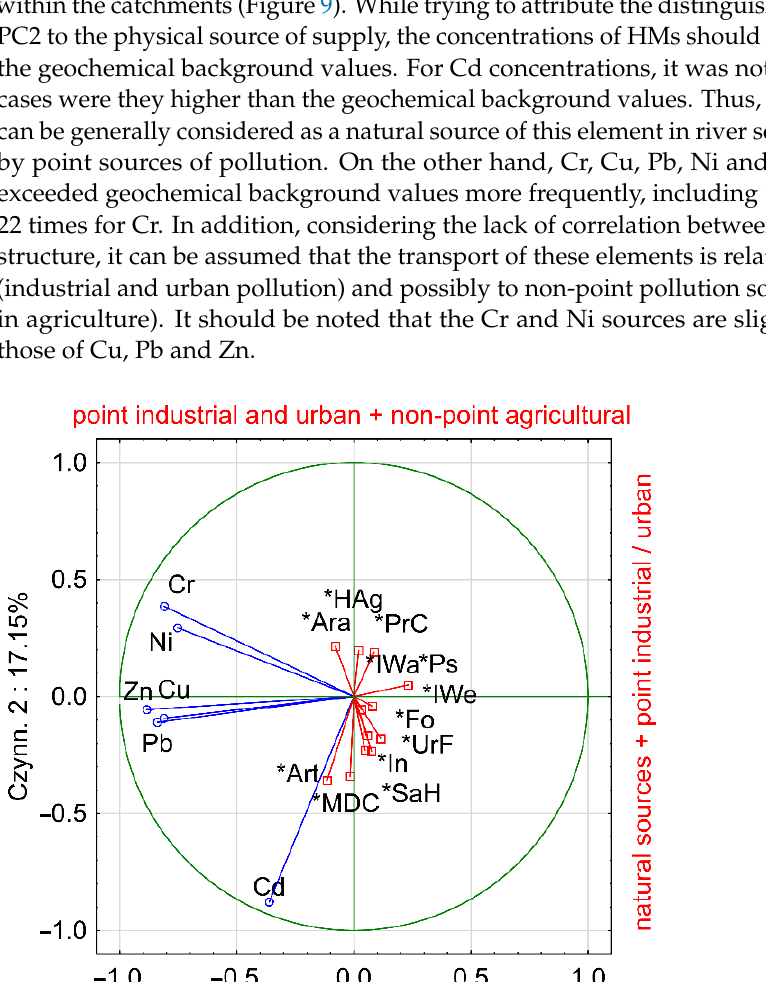
Figure 10. Source apportionment ( a – c ) and source contribution ( d ) to HM supply obtained by the PMF method. 4. Discussion In this study, HM concentrations and ecological risk were evaluated for 47 rivers lo- cated in Poland. Most previous studies were mainly related to the concentrations of rivers, lakes and reservoirs analyzed at the local and regional scale [15,18–20,22,24,31–35]. There is a lack of systematic study in the literature considering the analysis of HM concentra- tions for rivers located in nearly the whole area of the country. Analysis of a bigger group of rivers can help to understand the relationship between HM concentration and localiza- tion. In this study, Getis-Ord 𝐺 𝑖∗ statistical analysis demonstrated that in the case of Cd and Ni, hotspots appeared respectively in the southwestern and southern parts of Poland